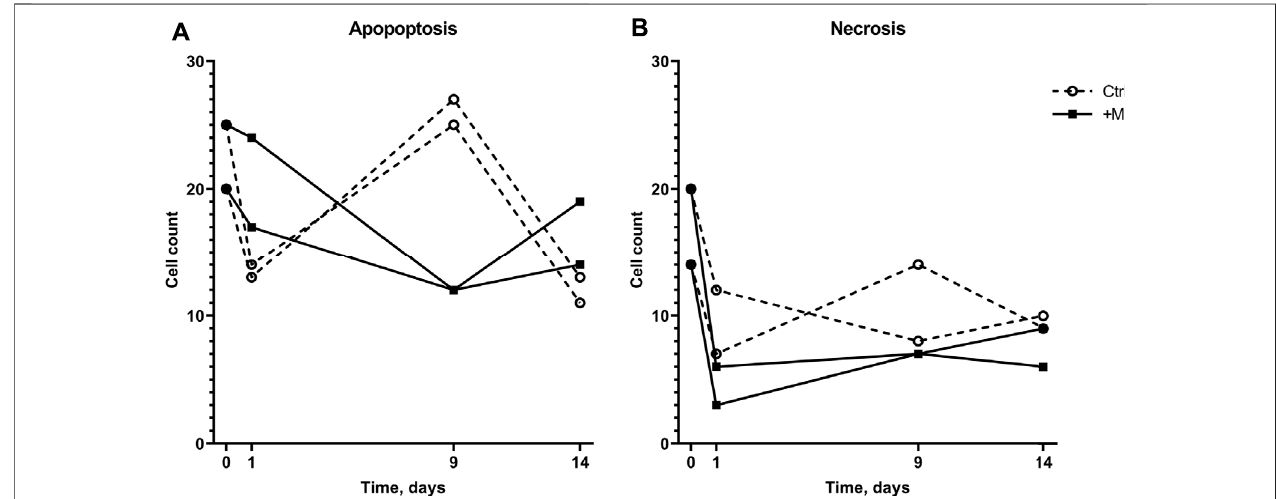
Frontiers in Bioengineering and Biotechnology |